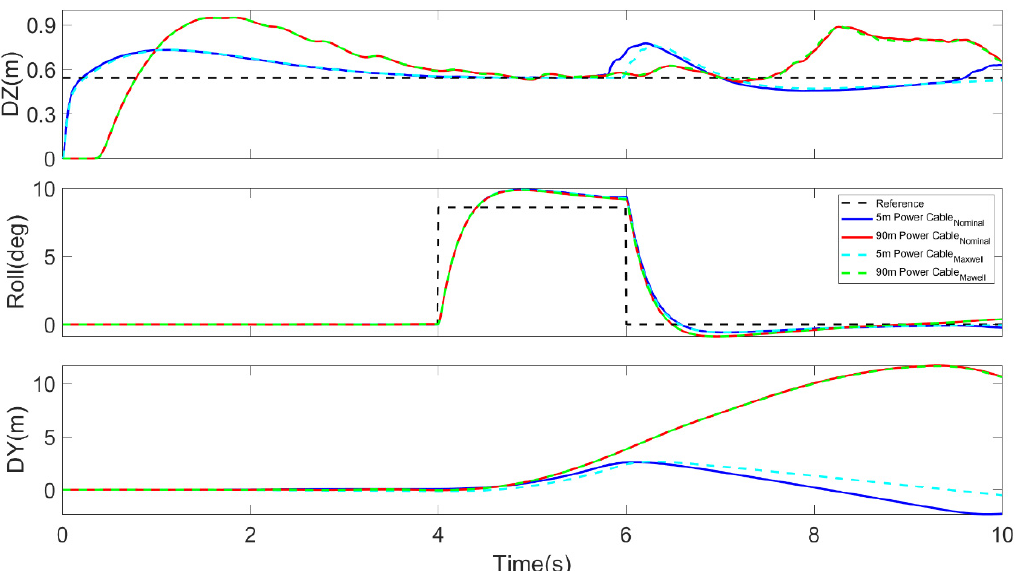
Figure 15. Altitude, roll attitude and horizontal position of the tethered multicopter during roll maneuver control simulation for various torsional stiffnesses and altitude conditions.